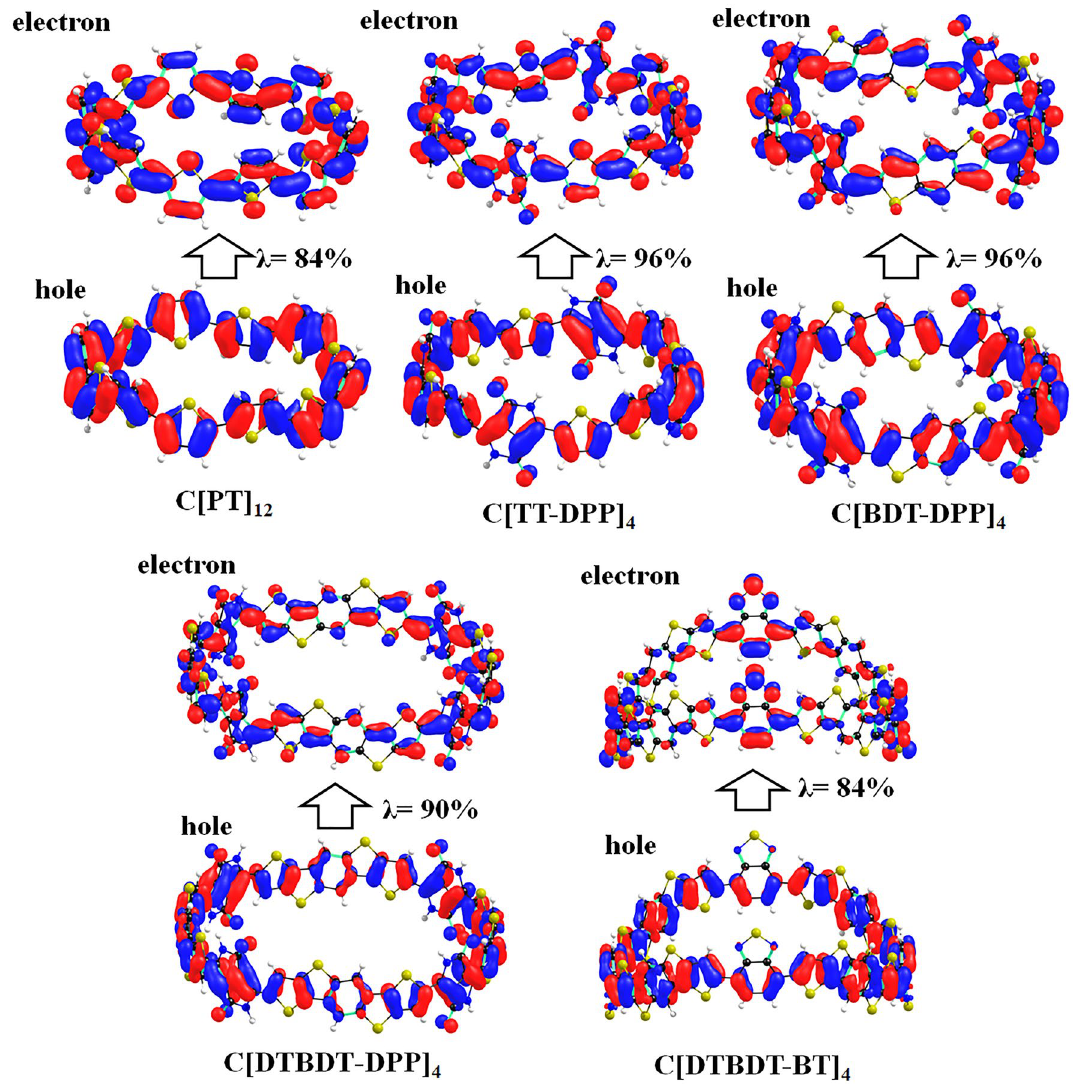
Figure 7. Pictorial representation of the natural transition orbitals of linear (C[PT] 12 , C[TT-DPP] 4 , C[BDT- DPP] 4 , C[DTBDT-DPP] 4 , and C[DTBDT-BT] 4 ) molecules corresponds to their lowest excited state (S 1 ) calculated at TD-mPW1PW91/6-31G(d,p) level of theory. Where, λ is the fraction of the hole–electron contribution to the